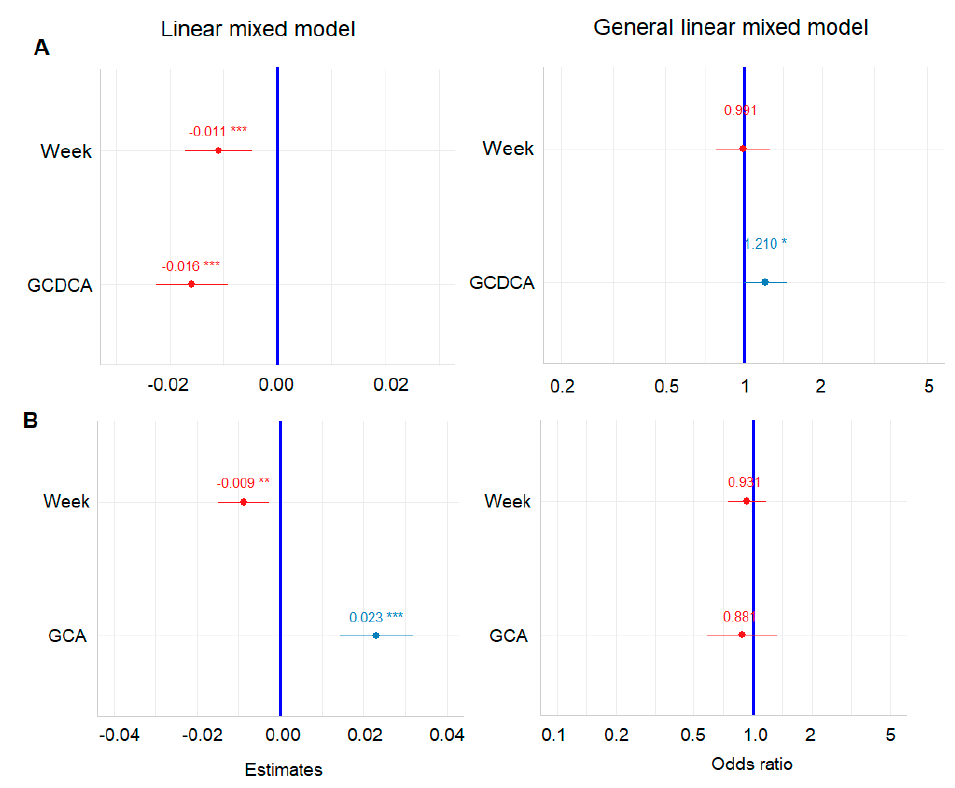
Figure 4. Estimates of coefficient and odds ratio of GCDCA composition (%) ( A ) and GCA compo- sition (%) ( B ) in the sBA pool as biomarker (predictor) in LMM and GLMM models, respectively. * p -value ≤ 0.05, ** p -value ≤ 0.01, *** p -value < 0.001. Color of dot indicate the factor/covariate has negative (red) or positive (blue) effects on ItchRO score in LMM model, and responder status, i.e., non-reponder 0 and responder 1, in GLM model; Whiskers span the 95% confidence interval, GCDCA, glycochenodeoxycholic acid; and GCA, glycocholic